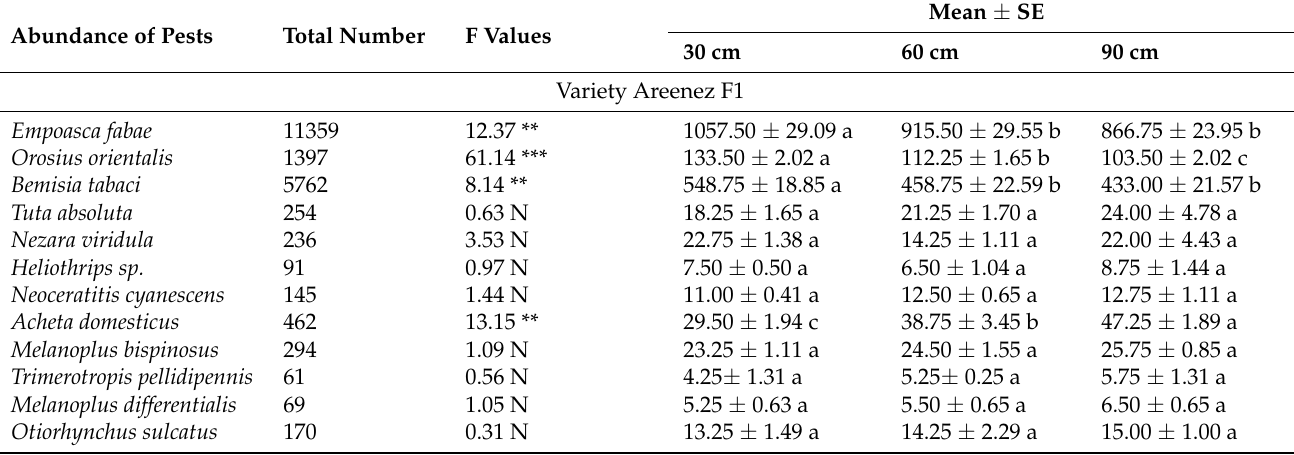
Table 2. F-values of ANOVA tests and their untransformed mean and standard error (Mean ± SE) of the effects of plant spacing (30 × 50 cm, 60 × 50 cm and 90 × 50 cm) on abundance of key insect pests (adults) across the tomato varieties ‘Areenez F1’ and ‘Tala